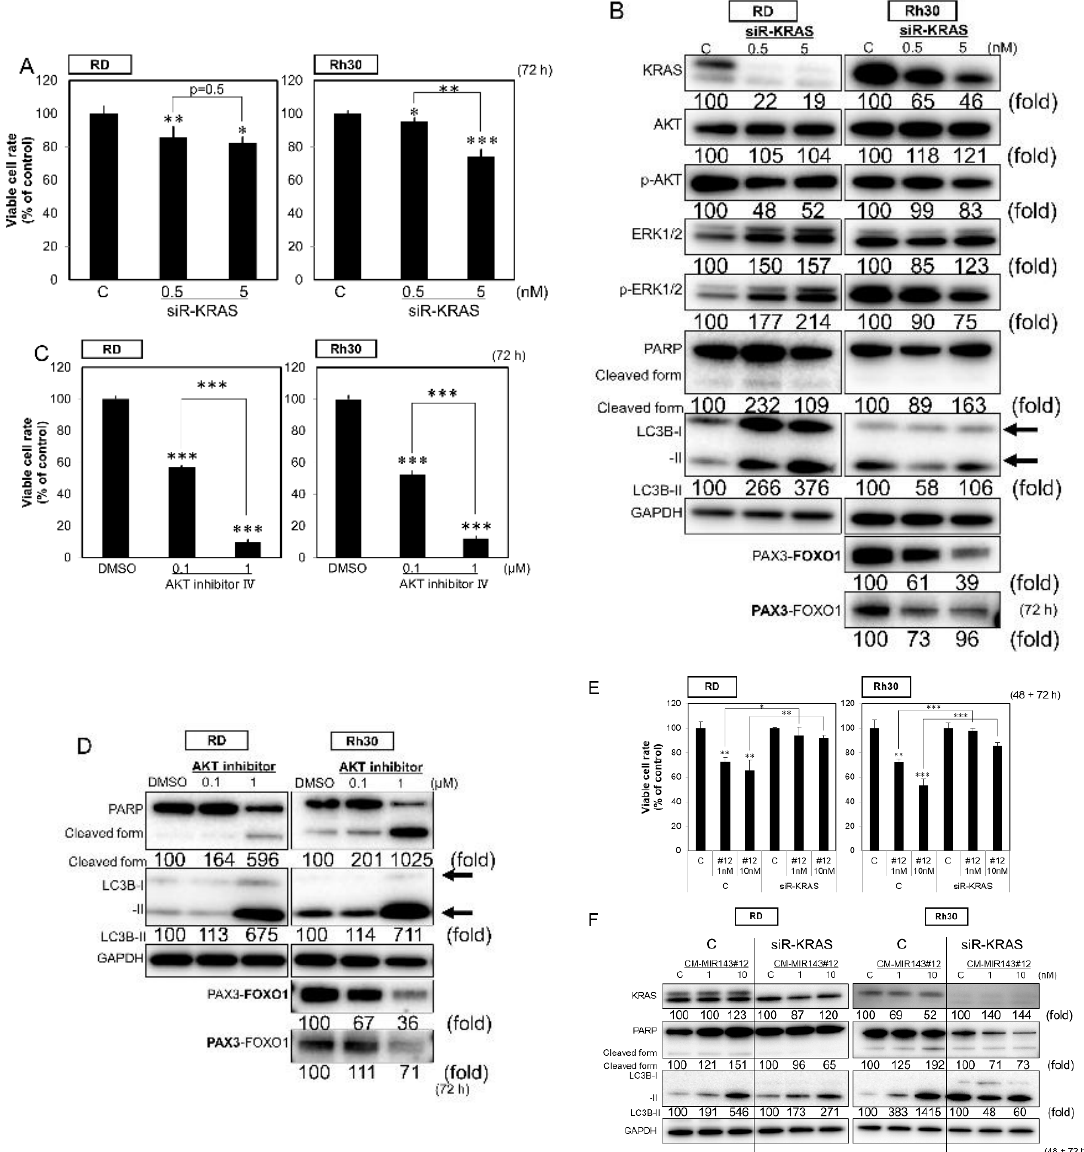
Figure 2. ( A , B ) Effects of ectopic expression of siR-KRAS on viability of RMS cells ( A ) and expression of KRAS, AKT, ERK1/2, PARP, LC3B, and PAX3–FOXO1 estimated by Western blot analysis ( B ) at 72 h after treatment of RD and Rh30 cells with siR-KRAS at a concentration of 0.5 or 5 nM. ( C , D ) Effects of AKT inhibitor IV on the viability of RMS cells ( C ) and the expression of PARP, LC3B, and PAX3–FOXO1 as estimated by Western blot analysis ( D ) at 72 h after treatment of RD and Rh30 cells with AKT inhibitor IV at a concentration of 0.1 or 1 µM. ( E , F ) Effects of ectopic expression of CM-MIR143#12 on the viability of KRAS-knockdown RMS cells ( E ) and expression of KRAS, PARP, and LC3B estimated by Western blot analysis ( F ) in RD and Rh30 cells treated with siR-KRAS (1 nM) for 48 h followed by CM-MIR143#12 transfection at a concentration of 1 or 10 nM for 72 h. PAX3–FOXO1 was detected using the antibody indicated in bold. Results are presented as the mean ± SD; * p < 0.05; ** p < 0.01; *** p < 0.001.